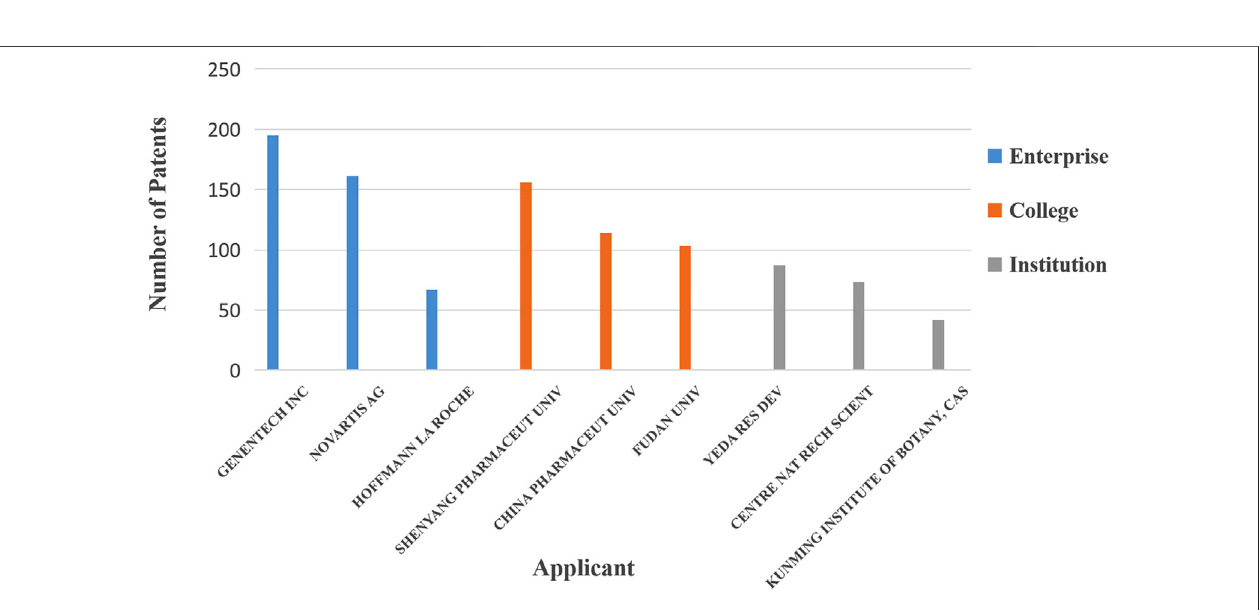
Frontiers in Pharmacology |